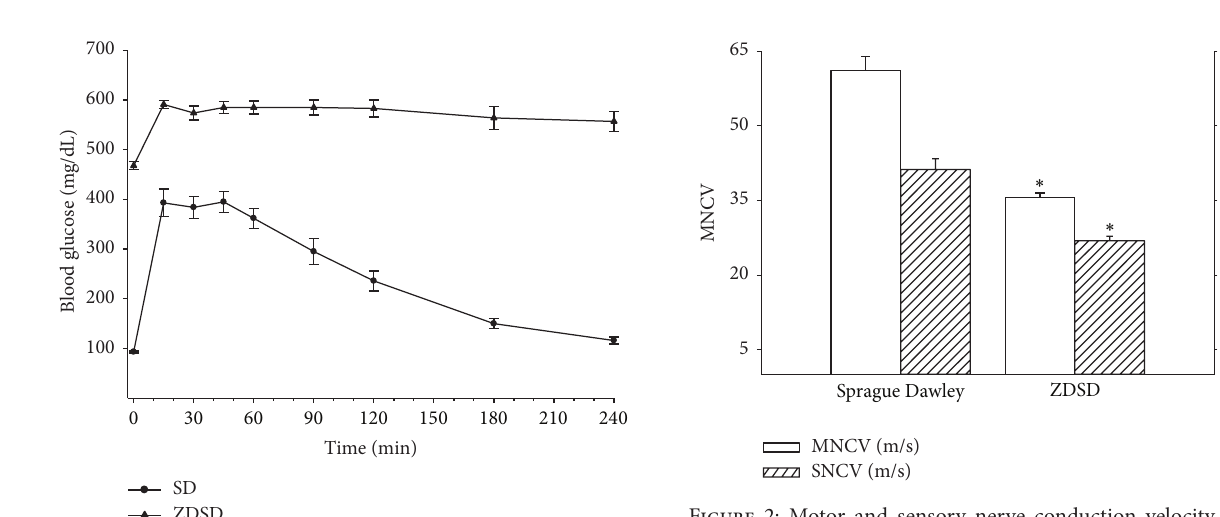
Figure 2: Motor and sensory nerve conduction velocity in age- matched Sprague Dawley and ZDSD rats. Motor and sensory nerve conduction velocities were examined as described in Section 2. The number of rats in each group was 10 and 9, respectively. Data are presented as the mean ± S.E.M for motor and sensory nerve conduction velocities in m/sec. ∗ 𝑃 < 0.05 compared to Sprague Dawley